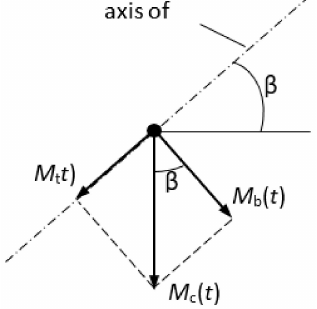
Figure 2. Interpretation of the lever angle β